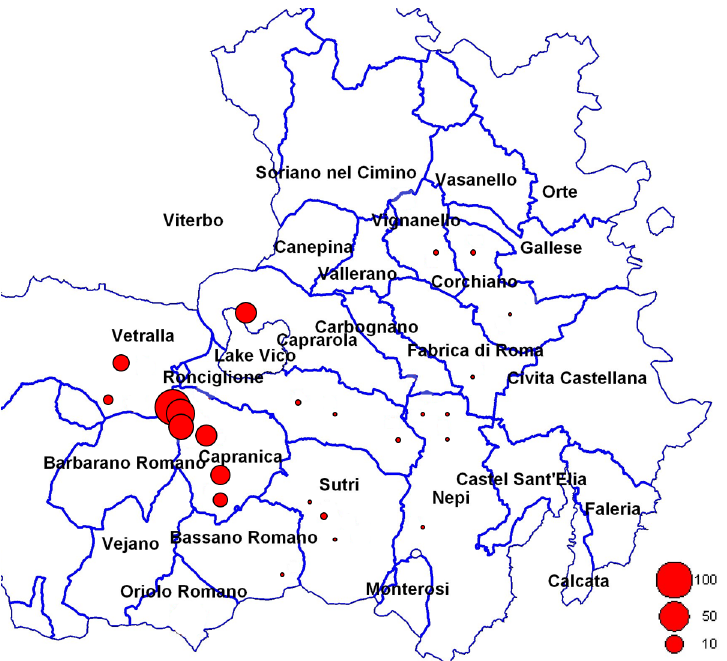
Fig 3. Incidence of hazelnut decline (%) across the study sites in the province of Viterbo. The circle size inside the map indicates the different hazelnut decline incidence.